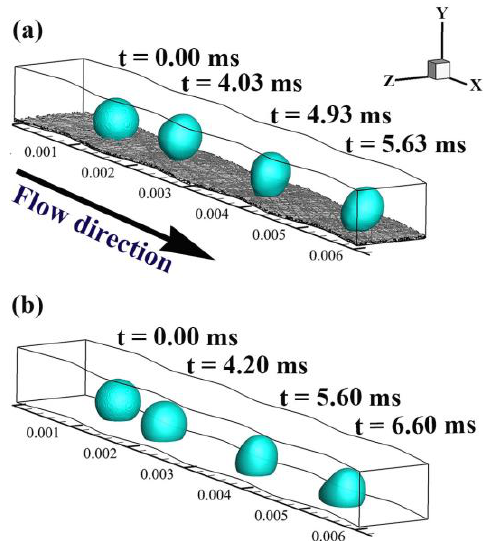
Figure 5. Comparative evaluation of droplet temporal evolution on: ( a ) rough; ( b ) smooth GDL surface at a static contact angle of 120˚.